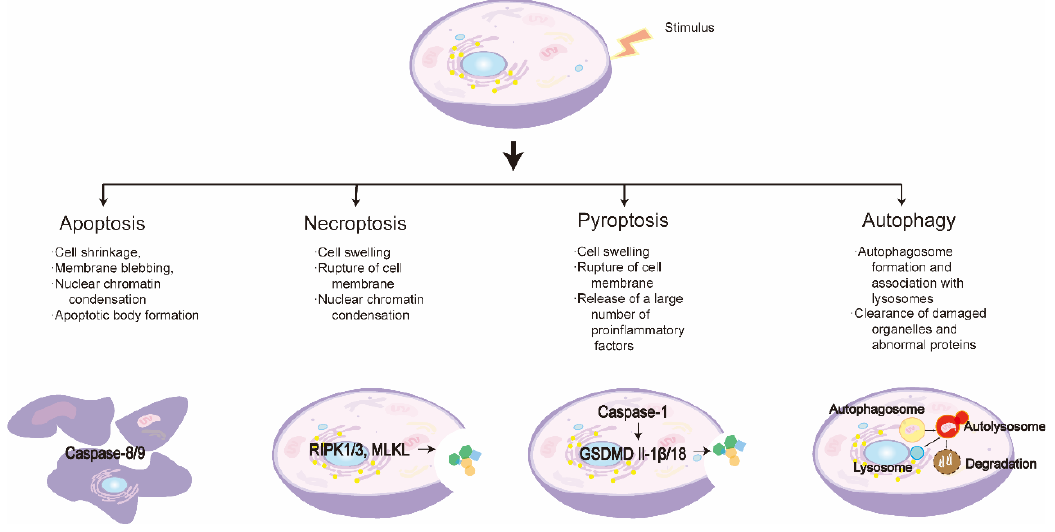
Figure 2. Characteristics of different programmed cell death pathways.